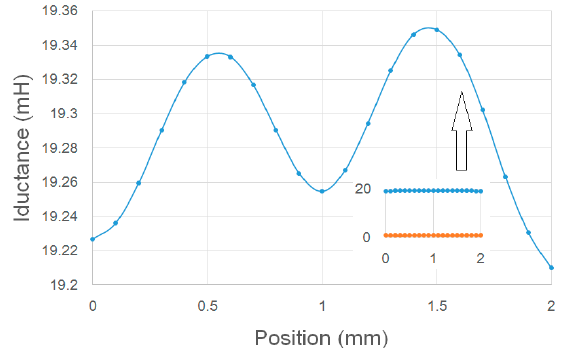
Figure 12. Self-inductance and mutual inductance of the machine.